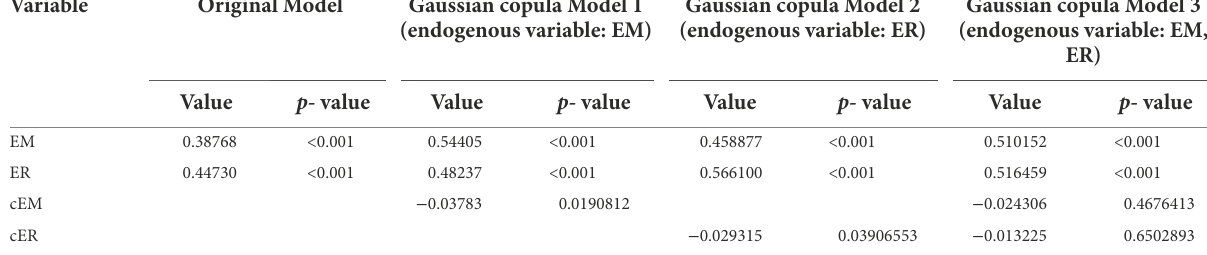
TABLE 10 Results of the Gaussian Copula approach.